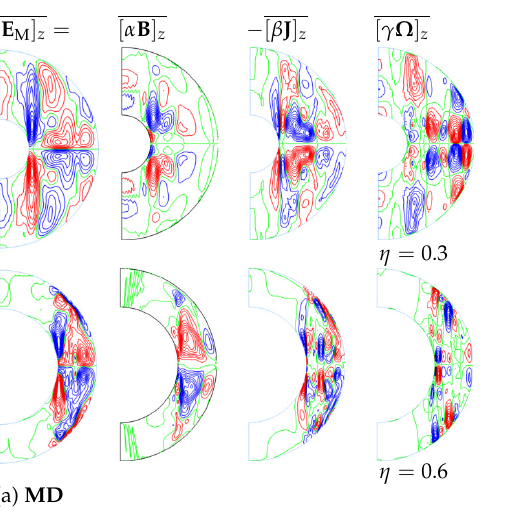
Figure 11. Spacial structures of the azimuthally-averaged z -component of the electromotive force E M and its α -, β - and γ -effect constituents as given by Equation (18). Four dipolar dynamo solutions are plotted as follows. ( a ) MD dynamo solutions with η = 0.3, P = 0.75, τ = 2 10 4 , R = 2,500,000, × 10 4 , R = 410,000, P m = 1.5 ( bottom row ). ( b ) FD P m = 1.5 ( top row ) and η = 0.6, P = 0.75, τ = 2 × dynamo solutions with η = 0.3, P = 0.75, τ = 2 10 4 , R = 2,500,000, P m = 1.5 ( top row ) and × η = 0.65, P = 0.75, τ = 2 10 4 , R = 300,000, P m = 1.5 ( bottom row ). In each column contour lines × of the quantities denoted at the column heading are plotted with positive contours shown in red, negative contours shown in blue, and the zeroth contour shown in green. (Colour